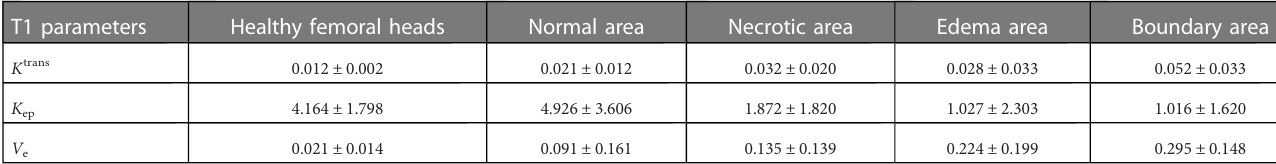
TABLE 3 Mean values of K trans , K ep , and V e in healthy femoral heads and different areas of necrotic ones. T1 parameters